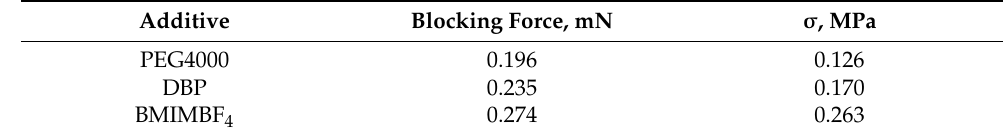
Table 8. The blocking force and maximum stress ( σ ) generated for OMIm actuators. Additive Blocking Force, mN σ , MPa PEG4000 0.196 0.126